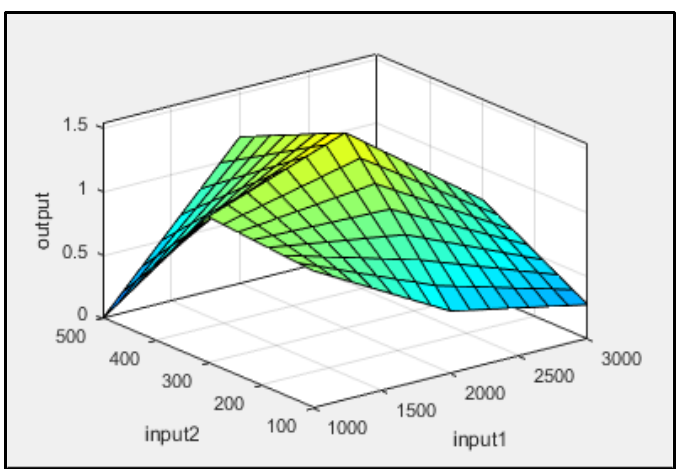
Figure 10. ANFIS regression line for testing.